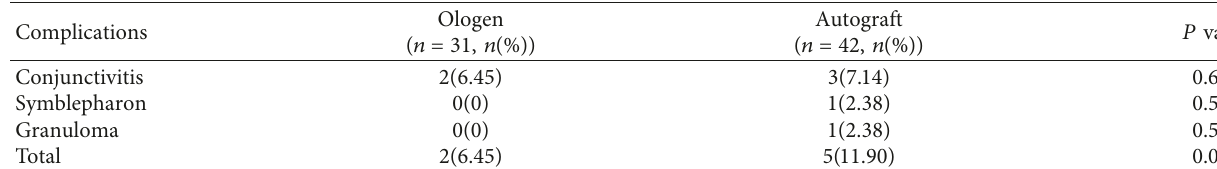
Table 3: The postoperative complications in both